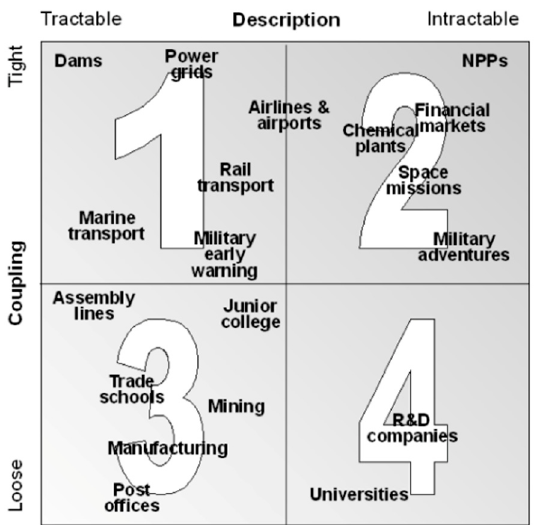
Figure 2. The coupling / tractability diagram by Hollnagel (2008), revised from Perrow’s original (1984) (with permission from Erik Hollnagel).